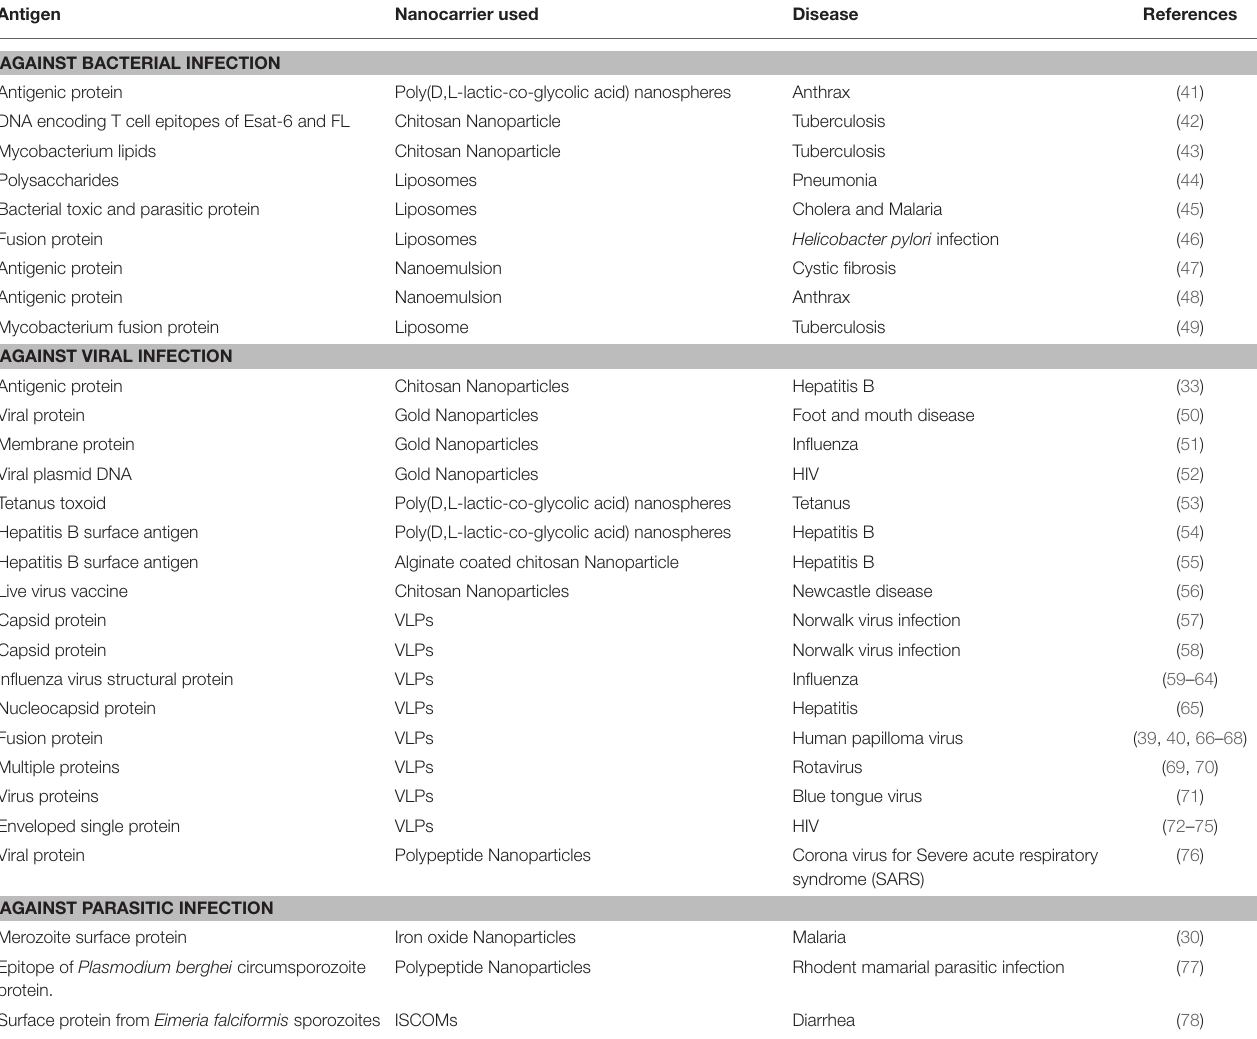
TABLE 1 | List of antigens delivered by using different nanocarriers for the treatment of different diseases.